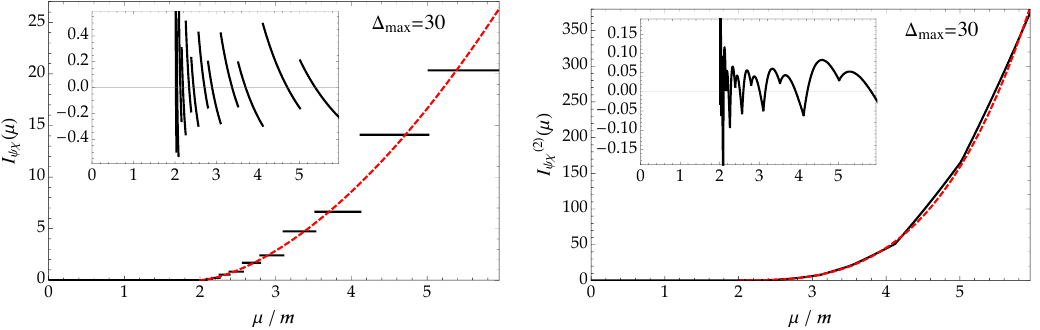
Figure 13 . Integrated spectral function I ( µ ) and doubly-integrated spectral function I (2) ( µ ) for the operator ψχ in the free massive theory, where the spectral function in the continuum is ρ ψχ ( µ ) ∝ (1 − 4 m 2 /µ 2 ) 1 / 2 . The truncation result at ∆ max = 30 is the black solid line, and the continuum result is shown in red dashed line. The relative error δI ≡ I trunc /I analytic − 1 is shown in the